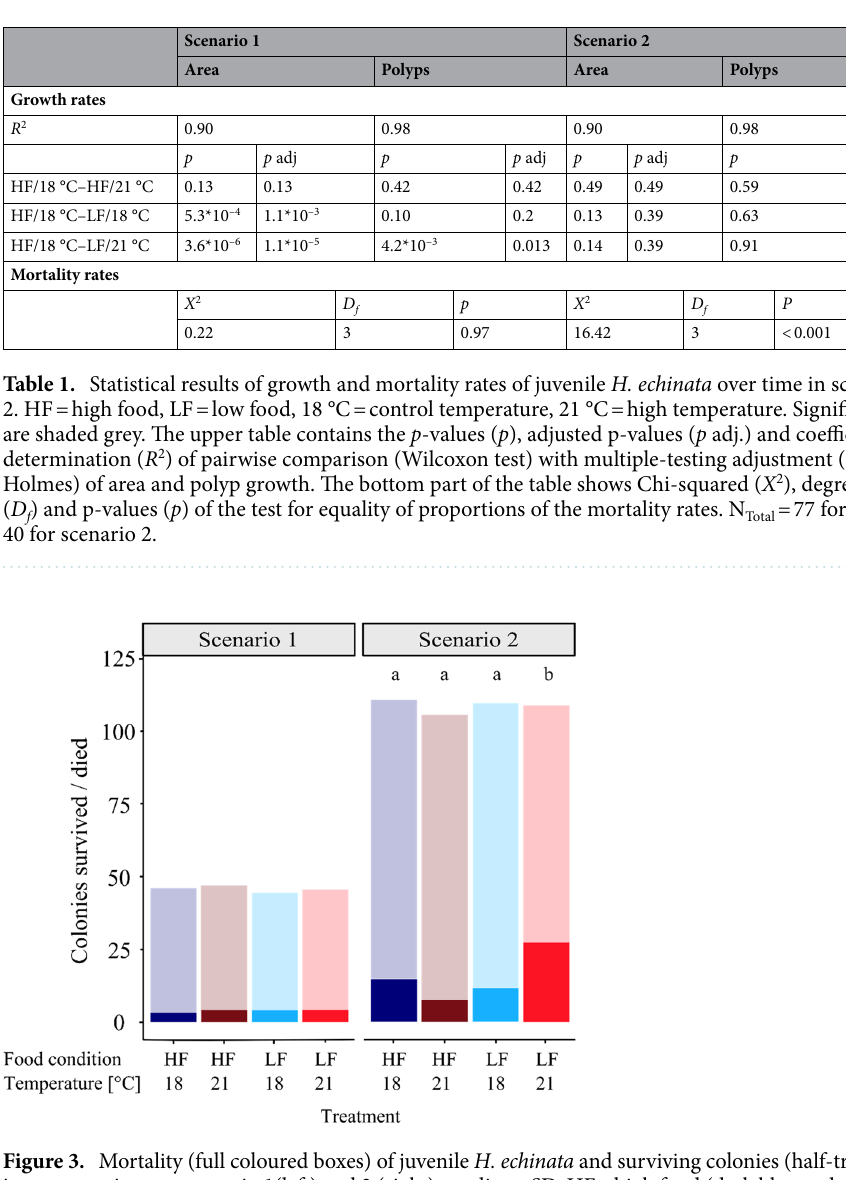
Figure 3. Mortality (full coloured boxes) of juvenile H. echinata and surviving colonies (half-transparent boxes) in two experiments, scenario 1(left) and 2 (right); median ± SD. HF = high food (dark blue and red boxes); LF = low food (light blue and red boxes); 18 °C = control temperature (blue boxes); 21 °C = high temperature (red boxes). All treatments in scenario 2 contained an extra temperature step of + 1.5 °C for six hours daily (see also Fig. 3). Significant differences between treatments are marked by lower